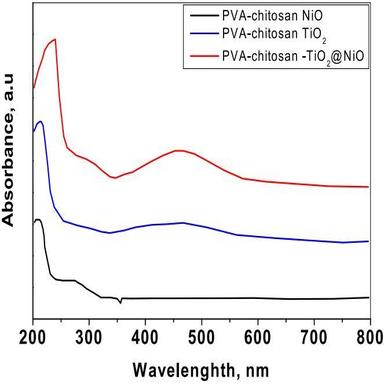
UV/vis. Absorbance spectra of PVA-chitosan–NiO, PVA-chitosan–TiO2, and PVA-chitosan–TiO2@NiO films.